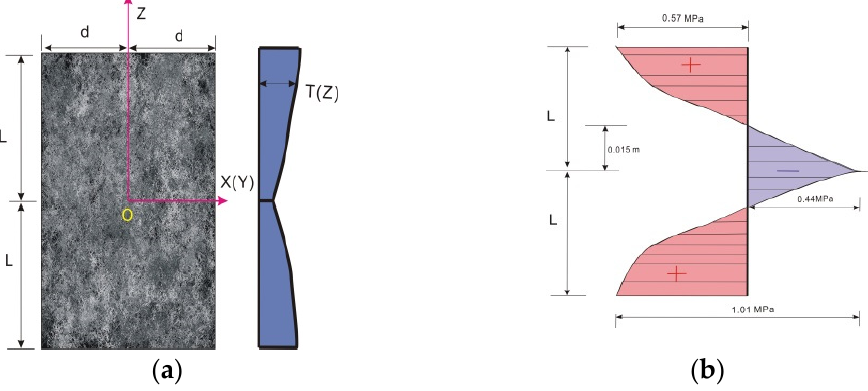
Figure 13. Temperature-induced stress distribution: ( a ) temperature distribution in the X–Z plane ( b ) temperature-induced stress distribution.